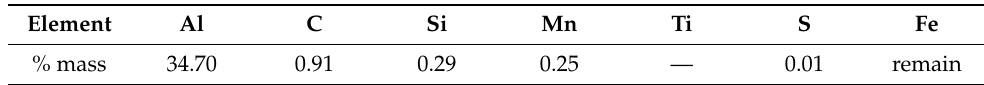
Table 2. Chemical composition of the investigated cast